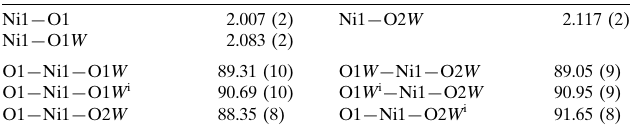
Selected geometric parameters (A˚ , (cid:2) ).